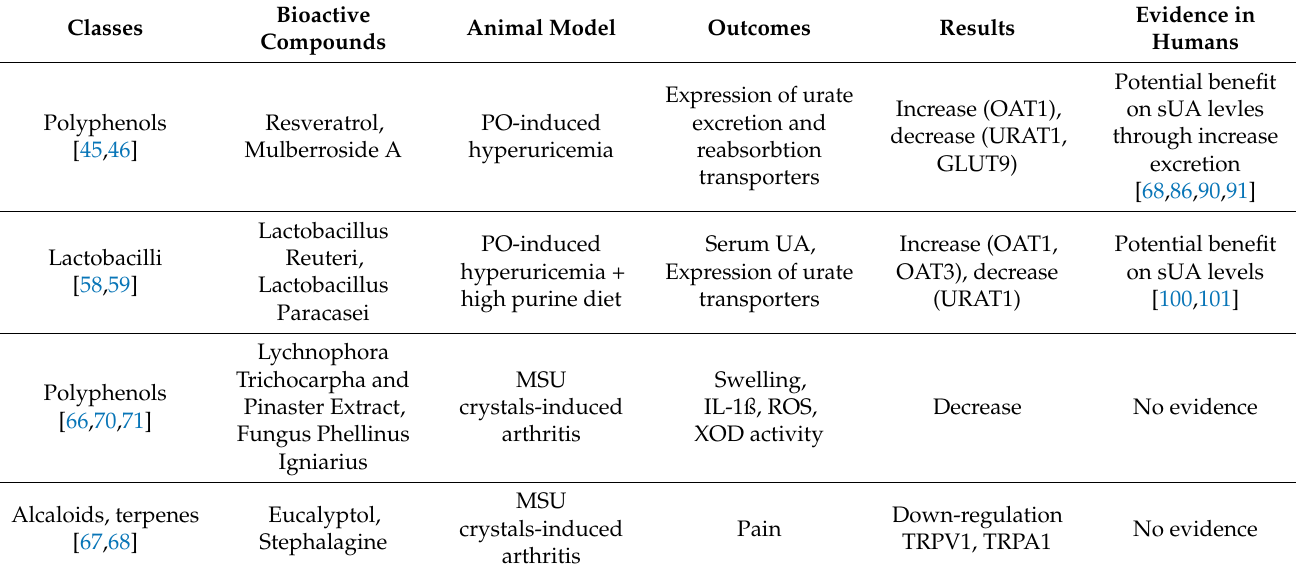
Table 4. Evidence supporting the potential activity of bioactive compounds in